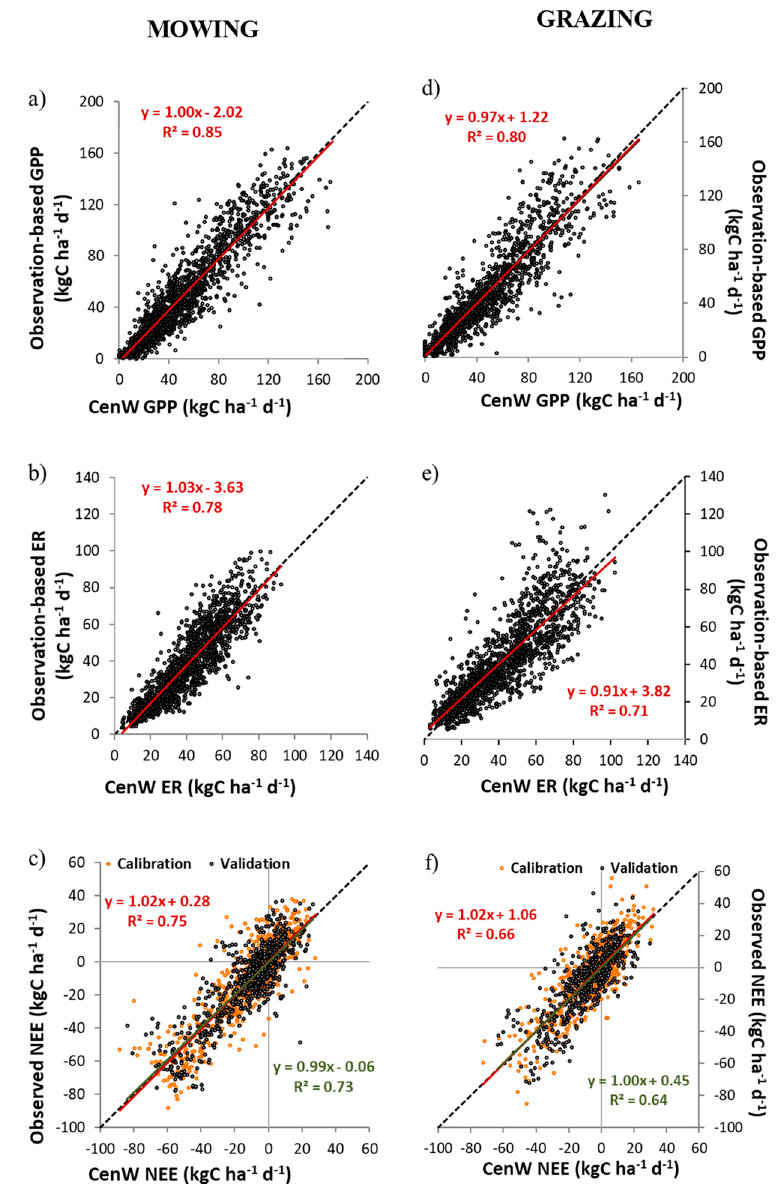
Figure 3. Scatter plots of observed vs. modeled daily carbon fluxes for the mown (panels a – c ) and grazed (panels d – f ) paddocks, for background measurement periods outside management (grazing, mowing) events. For NEE, negative numbers refer to carbon gain by the system. Corresponding e ffi ciencies for each comparison are given in Table model efficiencies for each comparison are given in Table 1.